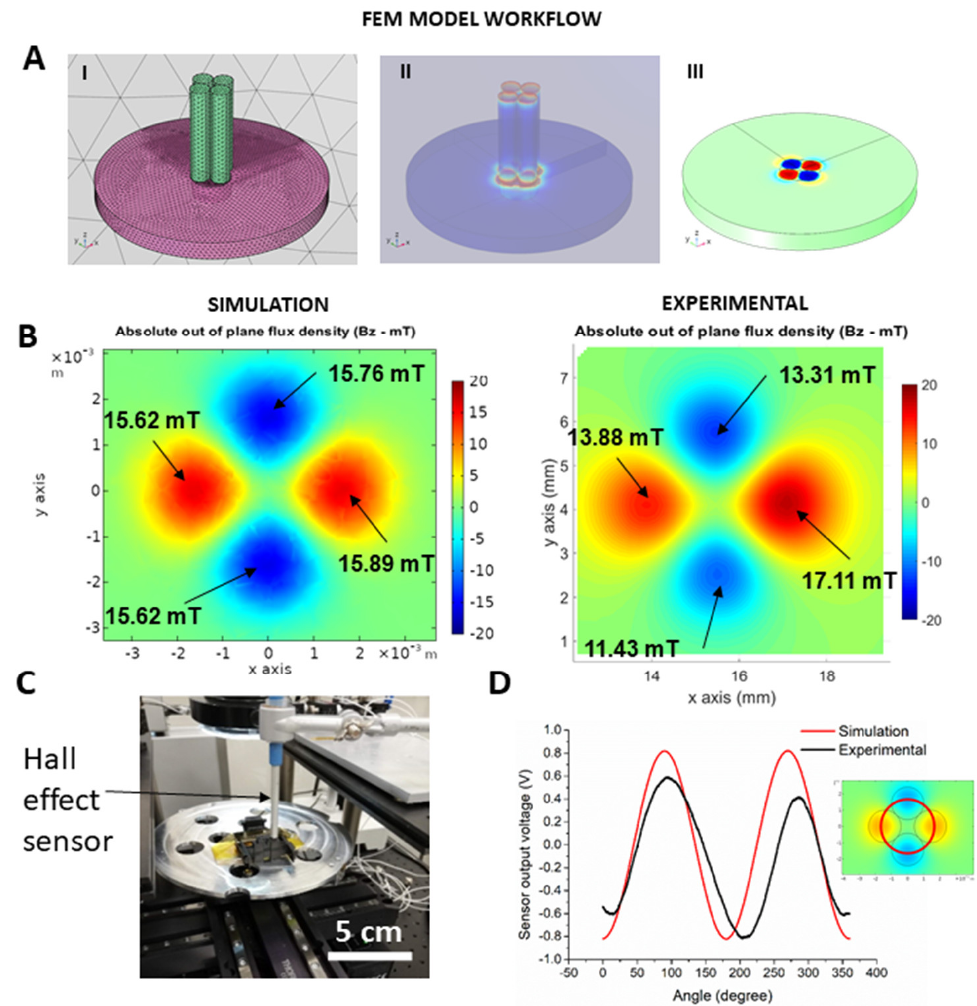
Figure 7. Use of the model for a magnetic encoder application: ( A ) Simulation of the magnetization pattern: (I) object drawing, material assignment and mesh generation; (II) computation of the mag- netic field generated by the magnet arrangement; (III) computation of the magnetic field generated by the magnetized MPC part. ( B ). Comparison of the simulated flux density and experimental measurements at 1 mm from the surface of the MPC object. ( C ). Measurement setup with rotation stage and Hall sensor. ( D ). Measured values at the same distance from the surface.